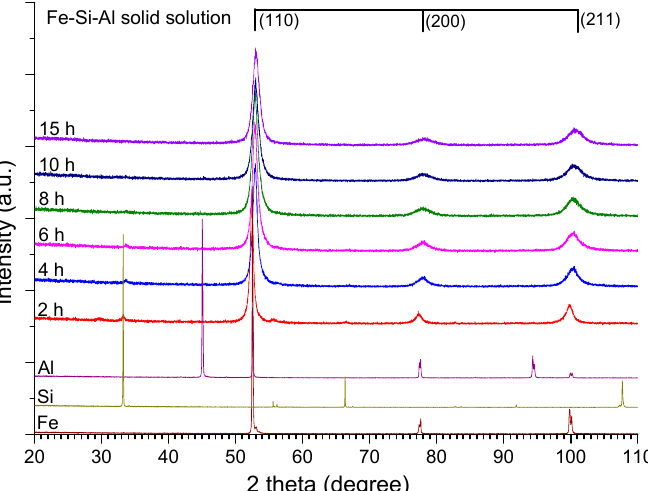
Figure 1. X-ray diffraction patterns of the Fe-Si-Al mechanically alloyed powder. The Fe, Si, and Al patterns are given for comparison.